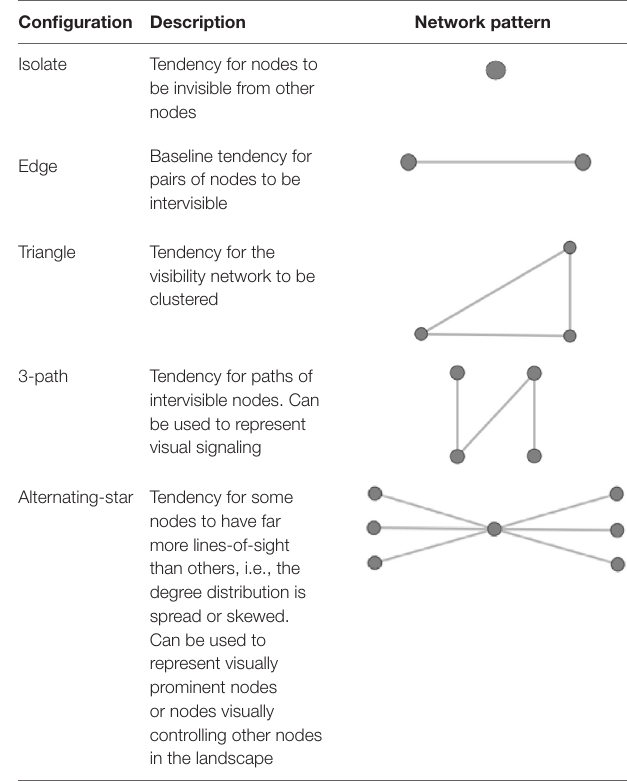
TaBle 2 | Configurations for theories of visibility networks in landscape